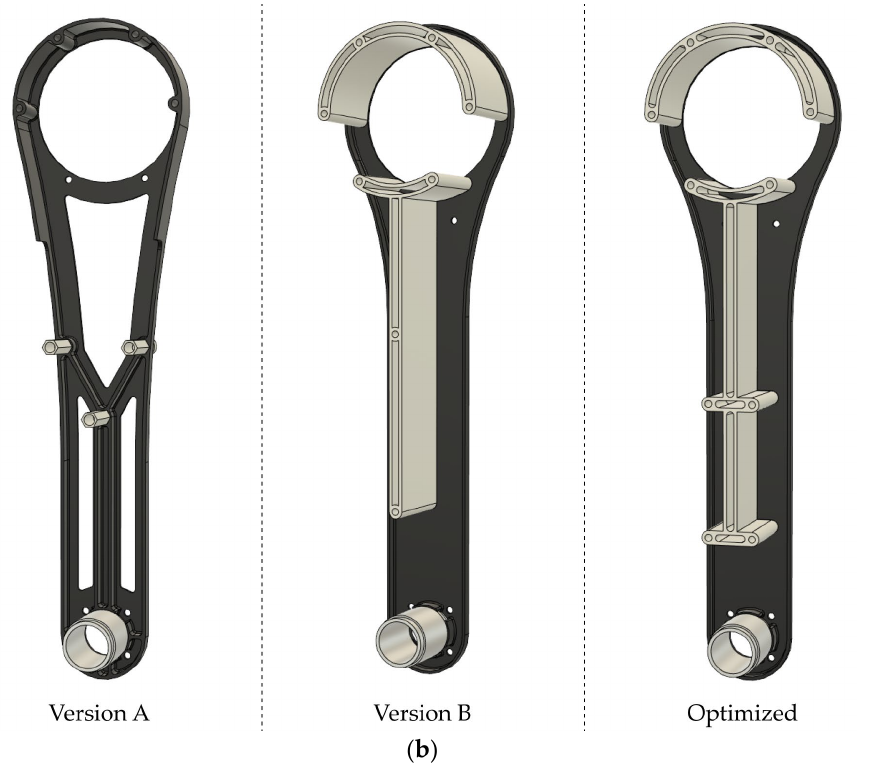
Figure 16. Optimization process for hip connector 2: ( a ) effect of different shapes on strength; ( b ) detailed display of different shapes.